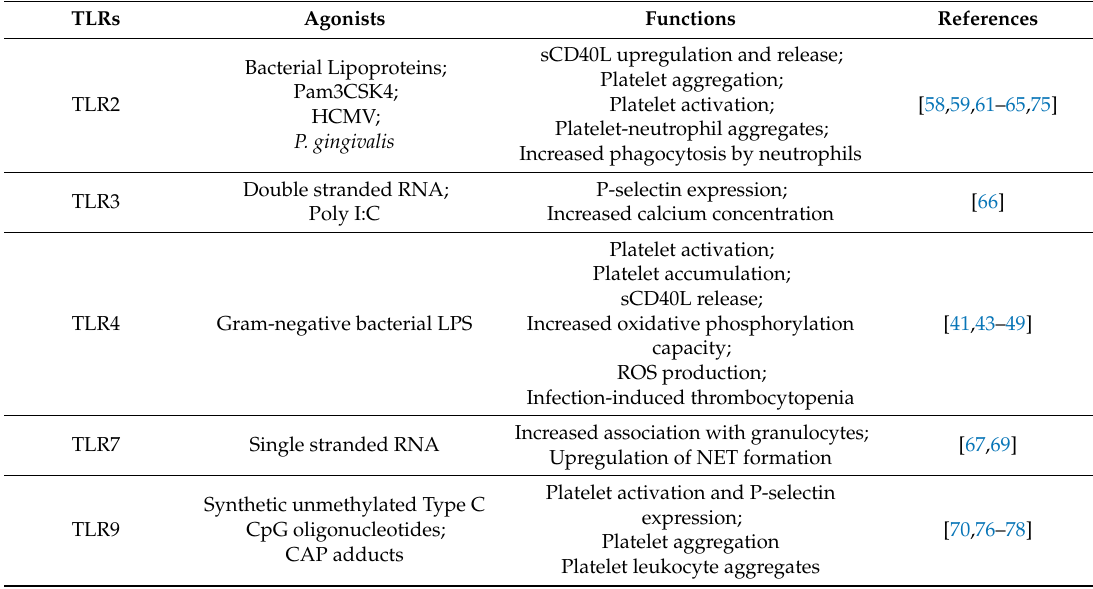
Table 2. Types of TLRs expressed by platelets and their role in